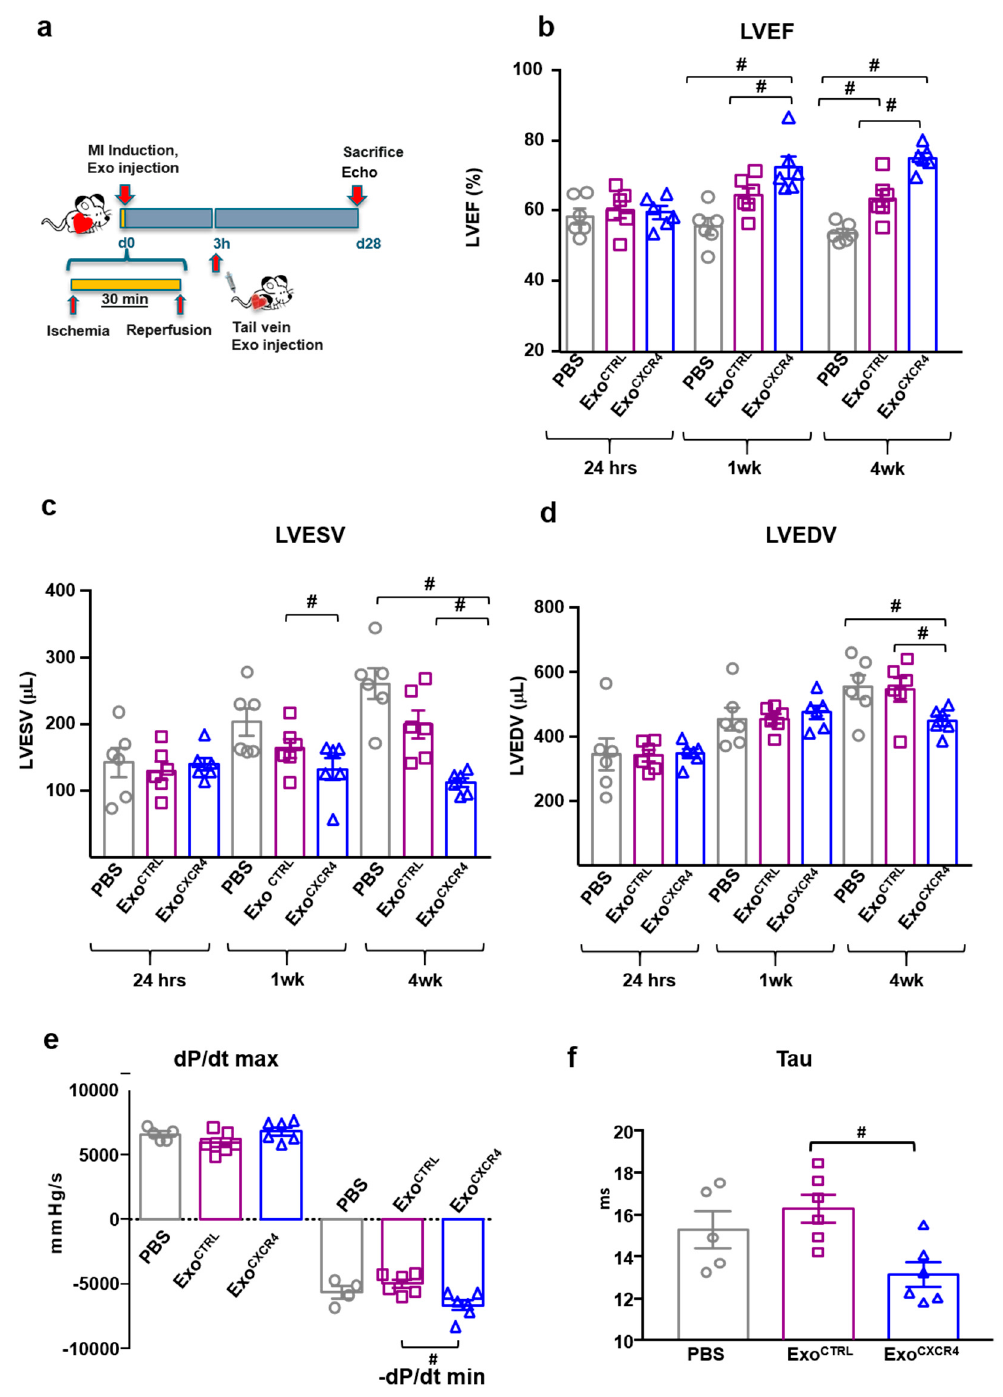
Figure 3. In vivo cardio-protection after I/R. ( a ) Scheme depicting the study protocol. I/R model was induced by ligating the left descending anterior coronary that was then released after 30 min. Exo (2 × 10 11 total particles from a pool of n = 6 patients, in 300 µ L PBS) were injected tail vein 3 h after reperfusion. ( b ) Exo CXCR4 but not Exo CTRL significantly improved LVEF at 7days after I/R, compared to PBS control group. At 28 days after I/R, Exo CXCR4 , and to a lesser extent Exo CTRL , significantly improved LVEF compared to control group ( n = 6 rats/group), # p < 0.05 (one-way analyses of variance-ANOVA with post-hoc multiple comparisons using the Tukey-Kramer multiple comparisons test for paired parametric comparisons; test was performed at each time-point). ( c , d ) Exo CTRL reduced both left ventricle (LV) end-systolic volume (LVESV) and left ventricle end-diastolic volume (LVEDV) was significantly less than modified Exo CXCR4 ( n = 6 rats/group), # p < 0.05 (one-way analyses of variance-